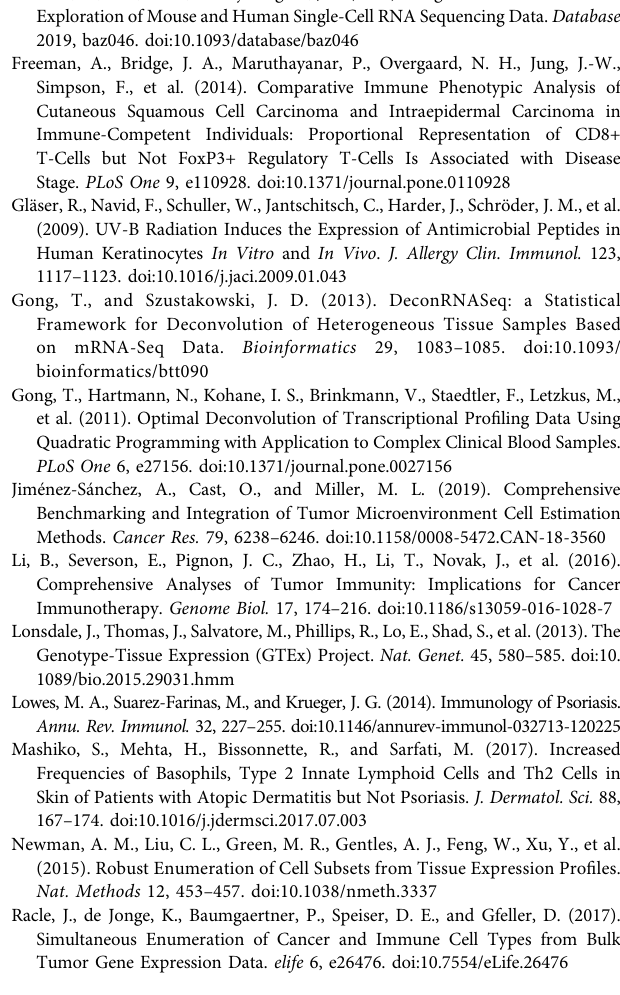
Supplementary Figure 1 | Bar plot of inter-method variability in Pearson ’ s R of correlation between decomposed and simulated cell fractions measured by IQR normalised by the number of cell types covered for each method in the simulation. MCP =